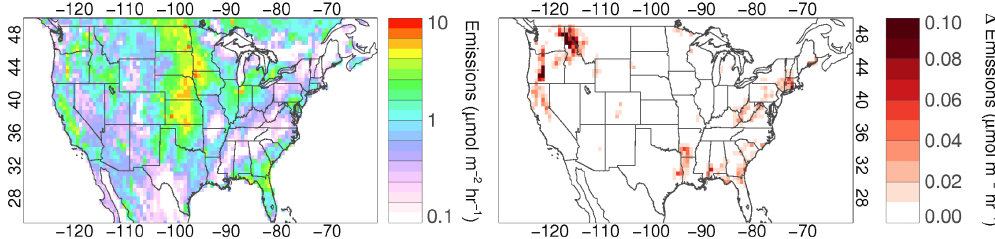
Figure 4. Mean JJA soil NO x emissions in the base scenario for (left), and the change in emissions resulting from predicted tree mortality